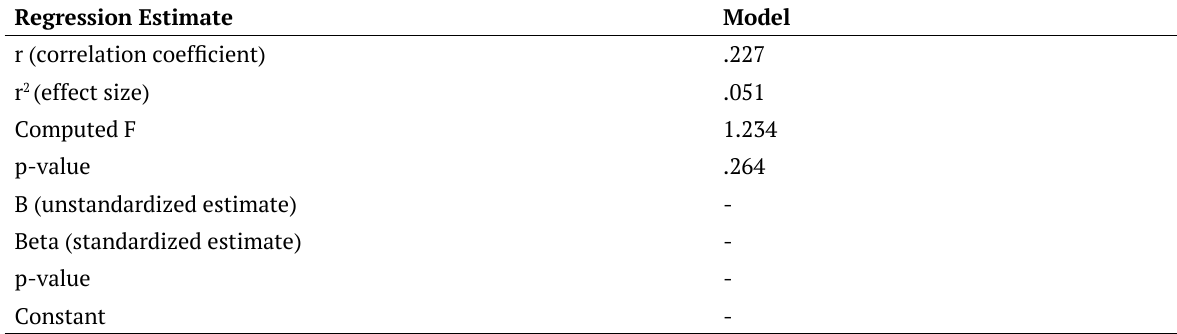
Table 11. Regression estimation procedures of the factors towards participants’ adaptability Regression Estimate